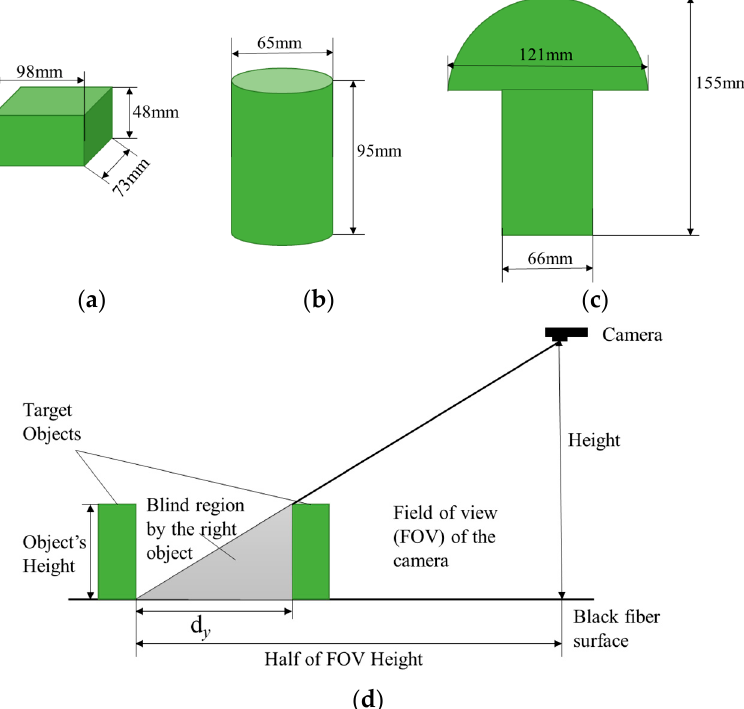
Figure 3. Illustration of the regular artificial objects and their dimensions. ( a ) A cuboid, ( b ) a cylinder and ( c ) a mushroom shape object consisted of a hemisphere and a cylinder. They are abbreviated as O1, O2 and O3 respectively, and three replicates of each object were marked using an underscore with a suborder number, for example O1_1, O1_2, O1_3. ( d ) Calculation of the distance between objects (d y ).